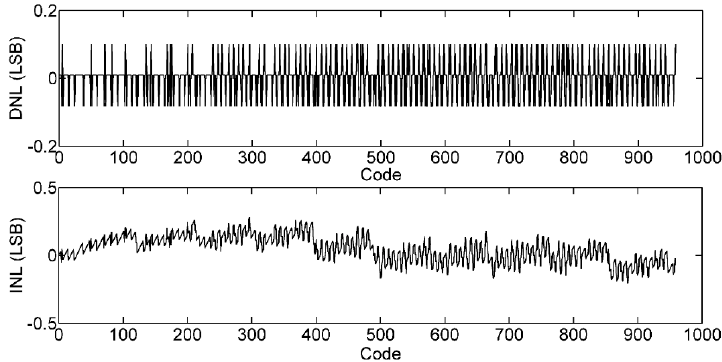
Figure 12. The DNL and INL of the proposed TDC.